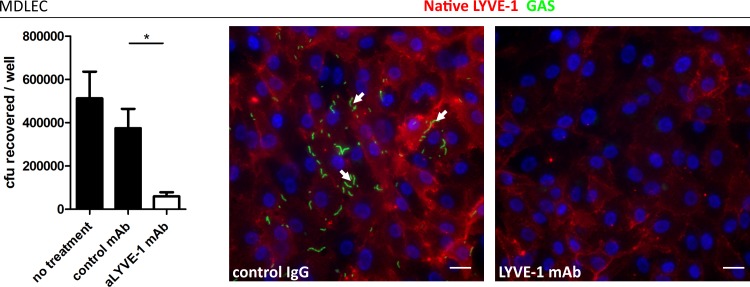
Murine LYVE-1 mediates GAS adhesion to MDLEC via capsular HA.Adhesion of M18 GAS to MDLECs. Left to right; numbers of adherent GAS were determined by quantitative culture (n = 4; Data represent mean+/-SD) (Mann Whitney U;* = p<0.05) and representative fluorescence microscopy of adherent GAS (30 min incubation) in the presence of control mAb or LYVE-1 blocking mAb. Scale bars (20 μm). Red = LYVE-1, green = GAS, blue = nuclei. Arrows indicate encapsulated GAS adhering to clusters of LYVE-1.